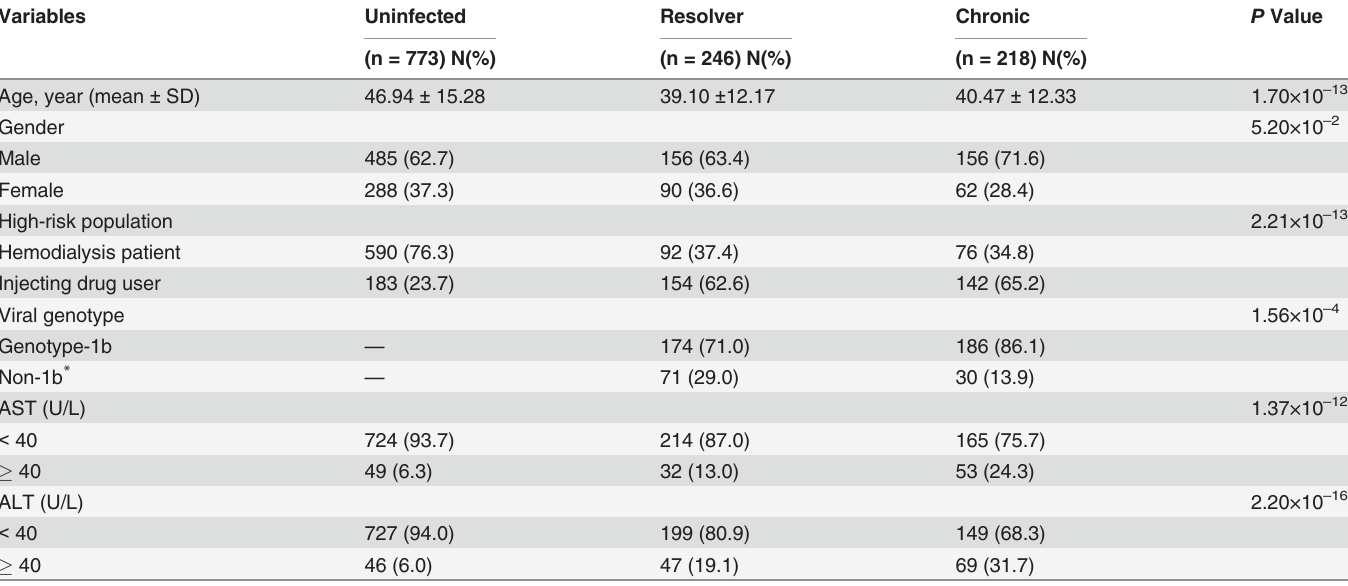
Table 1. Demographic and selected variables in subjects with different HCV infection